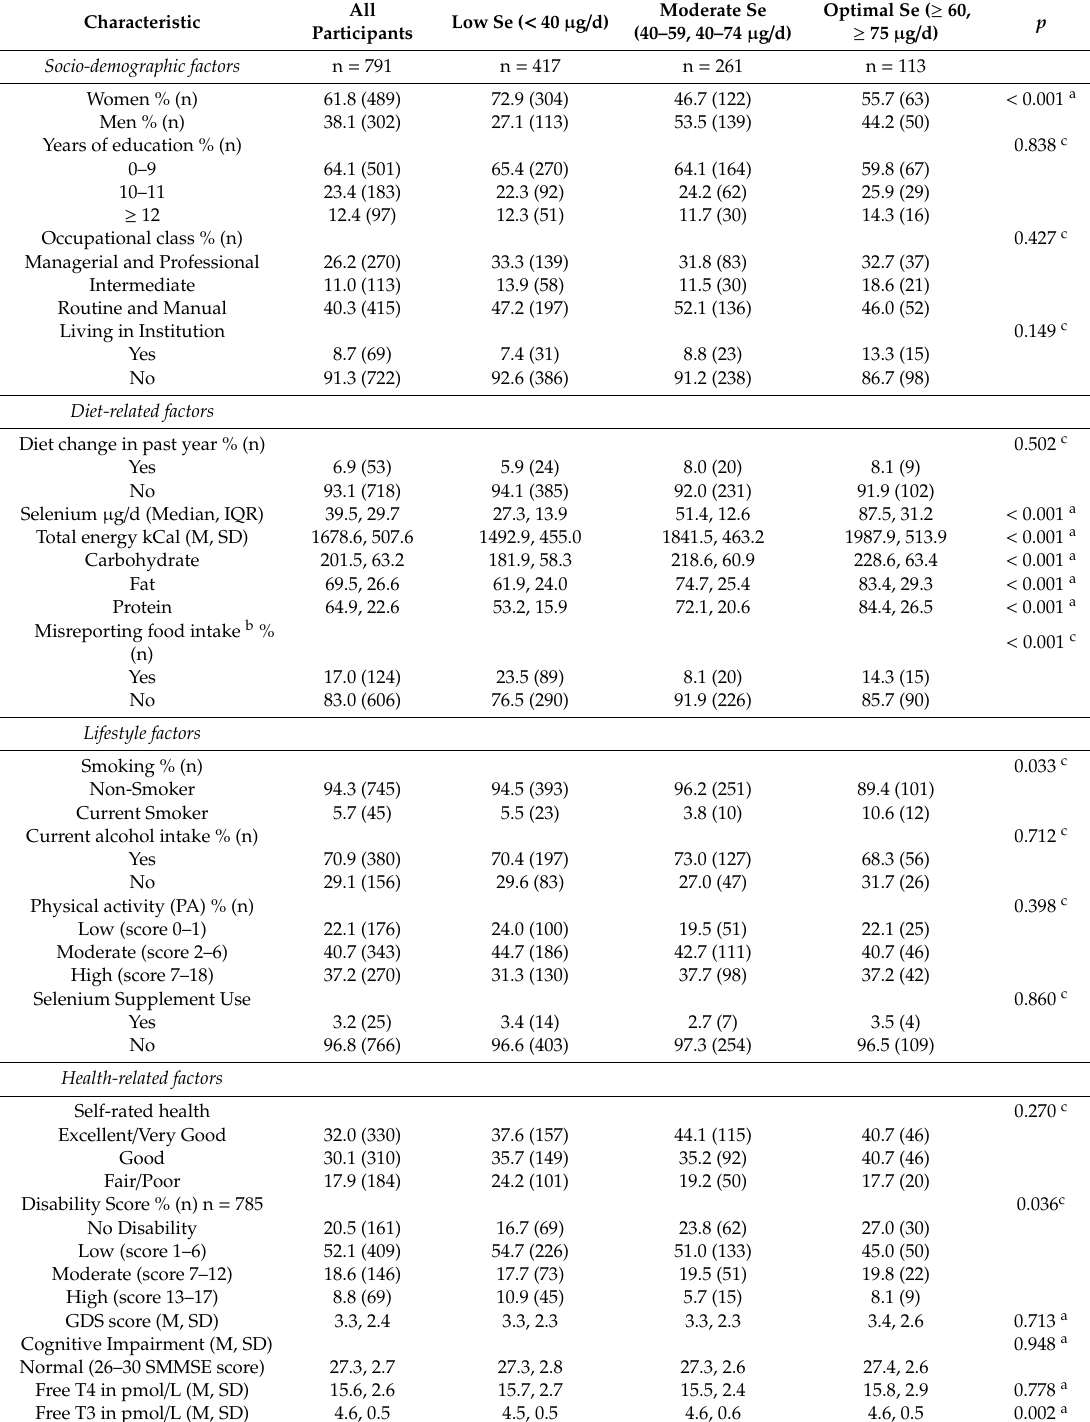
Table 2. Characteristics of study participants by selenium intake groups (low < 40 µ g / d, moderate 40–59, 40–74 µ g / d, good ≥ 60, ≥ 75 µ g / d for women and men, respectively) at